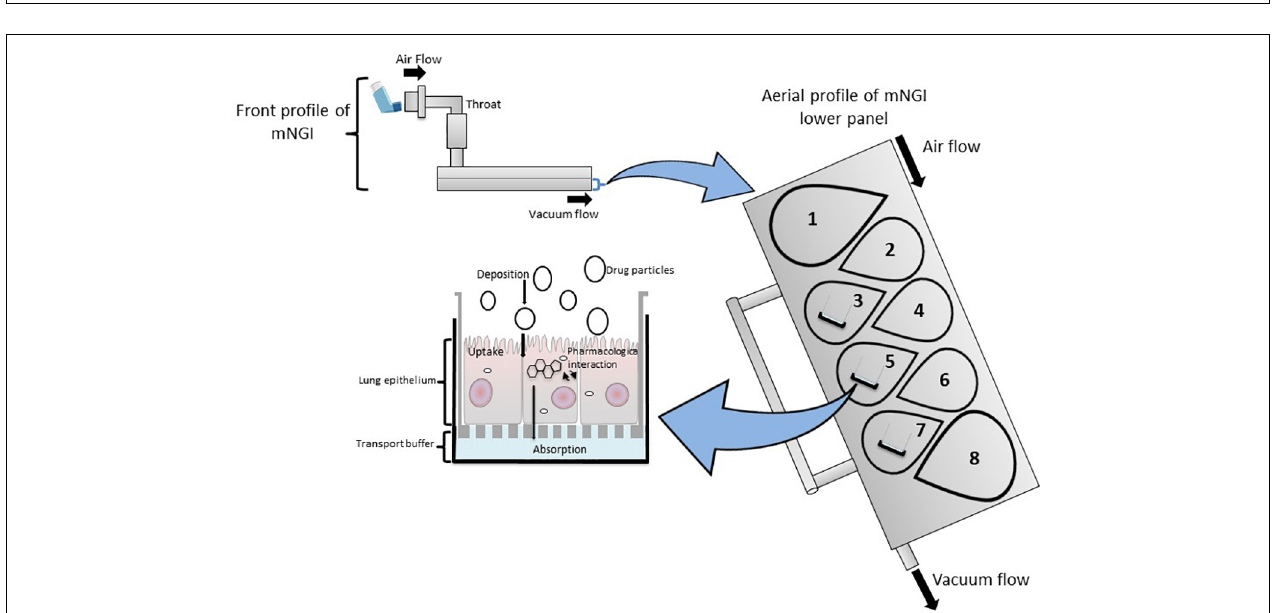
FIGURE 3 | Diagrammatic rrepresentation of a modified Anderson Cascade Impactor (mACI) with the incorporation of Snapwell or Transwell inserts embedded with respiratory cell lines at the air-liquid interface (ALI). Airflow is maintained at a controlled flow rate and generated via vacuum flow on the opposite end of the mACI to simulate airflow and allow for the assessment of mouth-to-airway transit of drug particles. Evaluation of aerosolized drug particle deposition, transport and absorption across the cell epithelia is determined through assessing inserted Transwells.